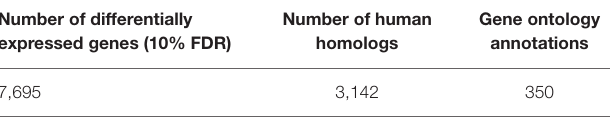
TABLE 1 | Number of differentially expressed EST’s between young and old colonies and number of those EST’s with human homologs and gene ontology